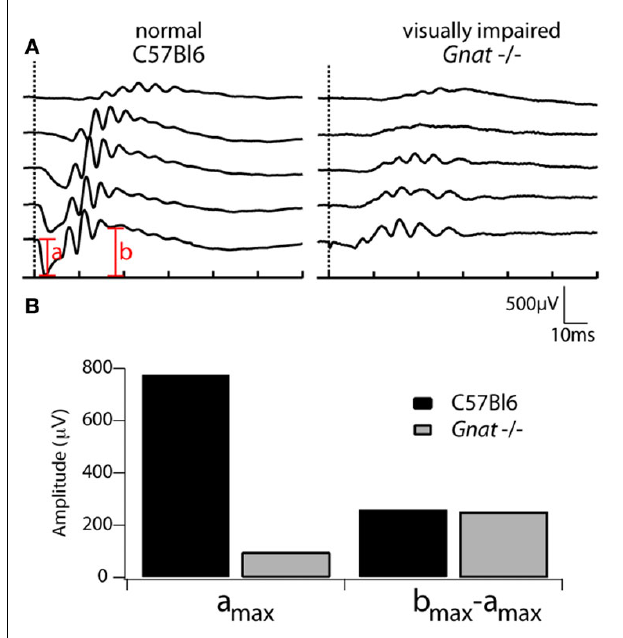
FIGURE 1 | ERG recordings in C57Bl6 and Gnat − / − mice. (A) Electroretinogram (ERG) recordings from a C57Bl6 control mouse and a Gnat − / − mouse. Brief (2 µs) fl ashes of 500 nm light (10 nm FWHM) were delivered at the time indicated by the vertical dashed lines. Light intensities activated 5–158,000 rhodopsins (R*)/fl ash and varied by 1.2 log units (normal) but much brighter fl ashes were needed for Gnat − / − mice, activating from 5,000–5 × 10 6 R*/fl ash. The a-wave, which is primarily mediated by rods (“a”) and b-wave, which is primarily mediated by ON-bipolar cells (“b”), are indicated in red. (B) Comparison of maximal a-wave and normalized b-wave amplitudes averaged from two wild type and two Gnat − / − mice. a was max measured from the pre-fl ash baseline to the peak of the a-wave at the brightest fl ash strength. Because there is minimal a-wave in Gnat − / − mice, b comparison was made from the pre-fl ash baseline to the peak of the max b-wave over a similar range of light intensities (b –a max max